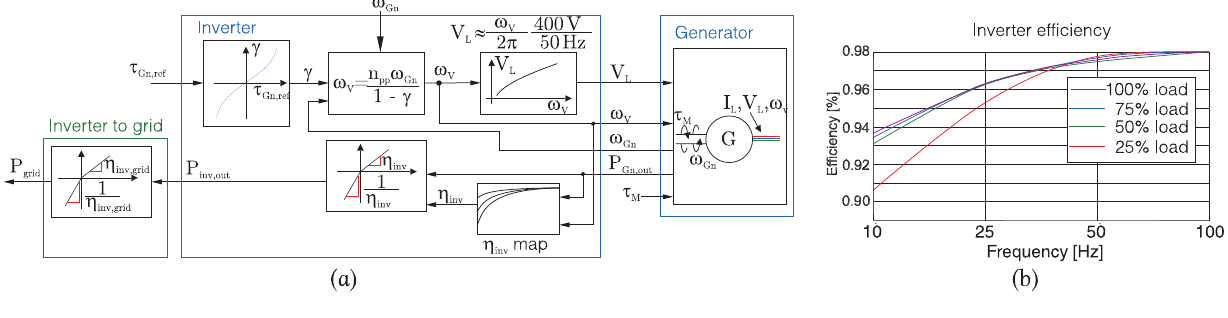
Table 4. Parameter values used for the hydraulic motor, generator and inverter system, where “Par.” and “Val.” abbreviate parameter and value,